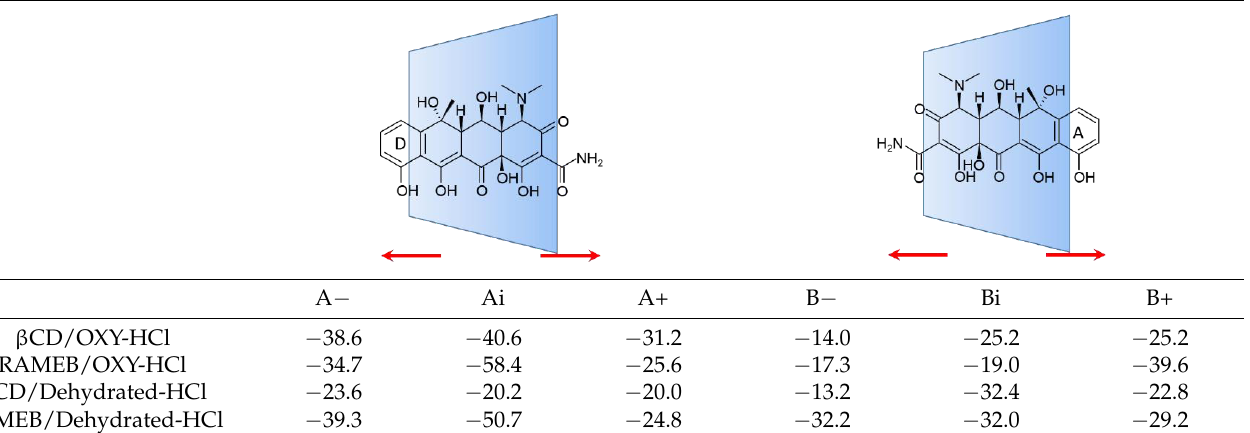
Table 3. The heat of formation differences (Kcal/mol) of the complete and incomplete inclusion compounds between CDs and oxytetracycline, relative to the free components.